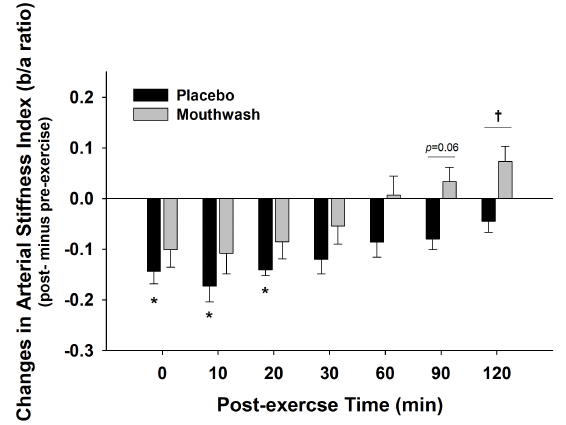
Fig. 4. Changes (post- exercise minus pre-exercise values) in the arterial stiffness index (b/a ratio) during the recovery pe- riod (0 to 120 min). Values are presented as mean ± SEM. *, p < 0.05 compared with pre-exercise values. †, p < 0.05 between treatments.